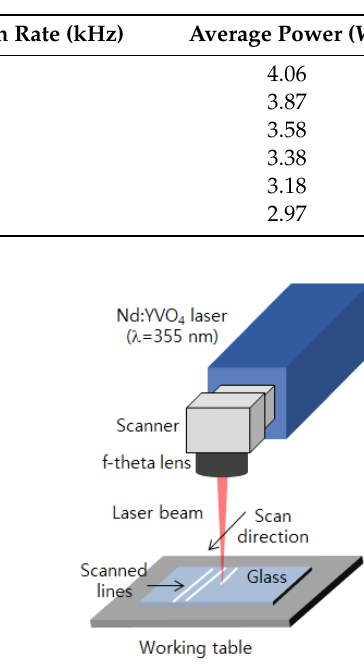
Table 1. Pulse width of the Nd:YVO 4 (355 nm) laser at di ff erent pulse repetition rates (data from INNGU LASER).